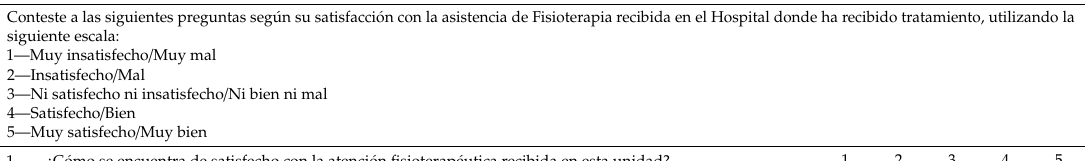
Table 5. Evaluator manual and the items of the Spanish validated Hospital Physical therapy Perceived Satisfaction